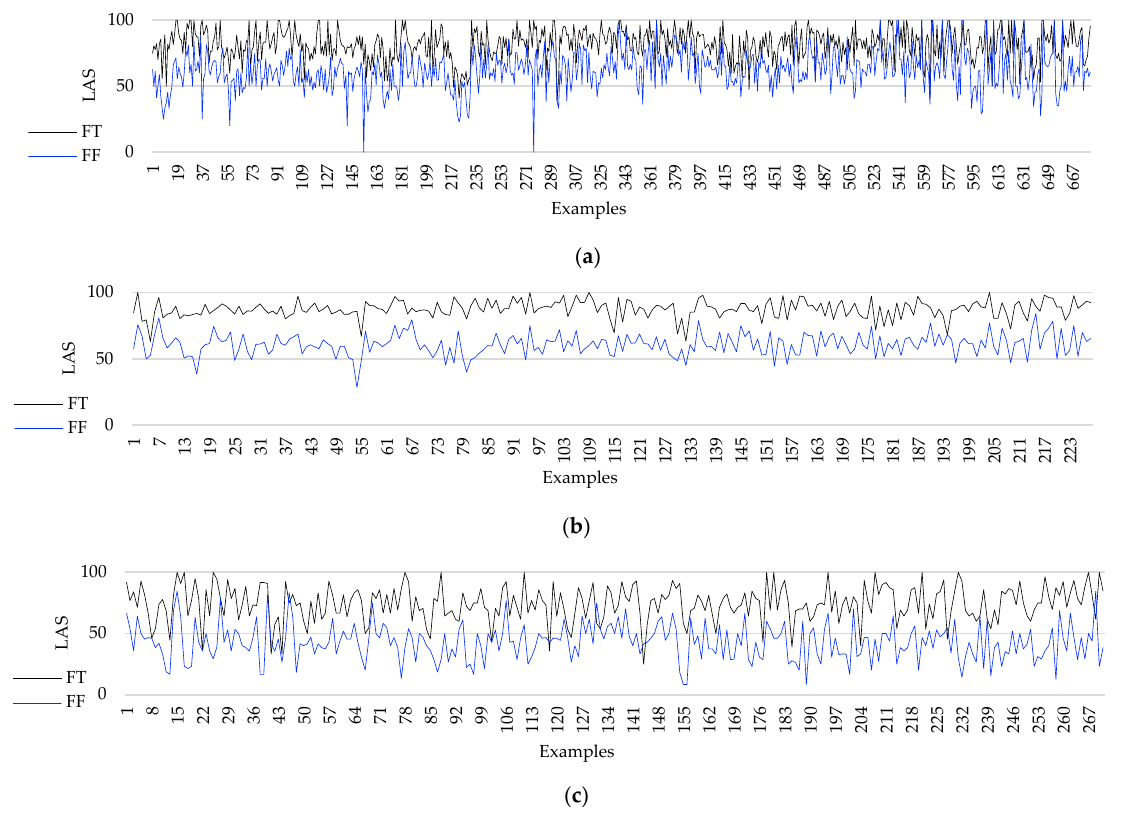
Figure 6. LAS for Fully Tuned (FT) and Fully Freeze (FF) models on all test examples. ( a ) PADT. ( b ) CATiB. ( c ) ArPoT.